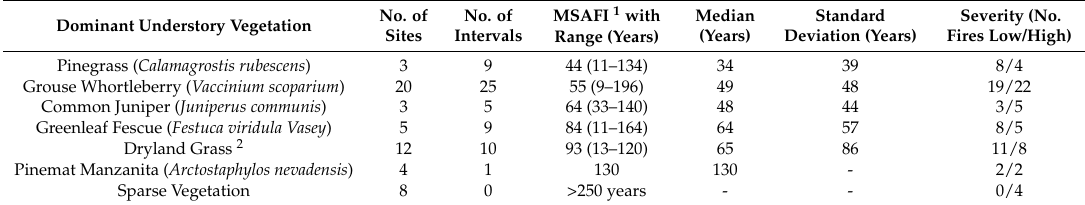
Table 4. Comparison of fire intervals and severities for each understory forest community type.